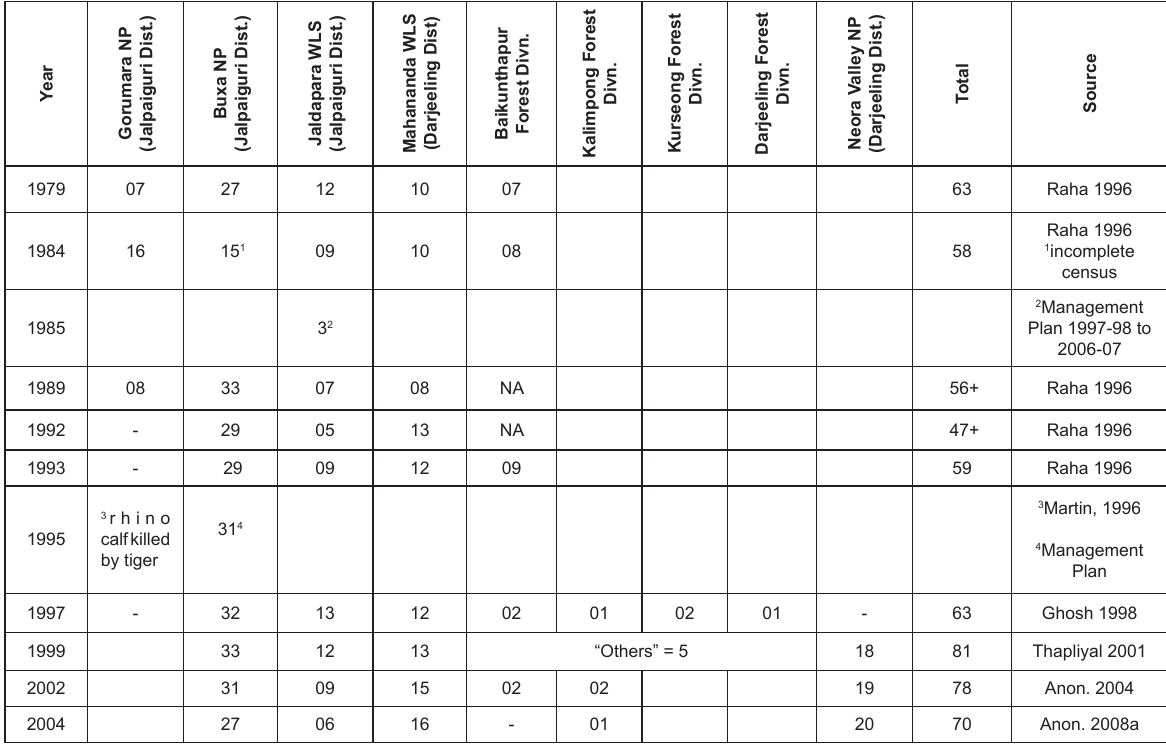
Table 1. Population of tiger in northern West Bengal during 1979-2004